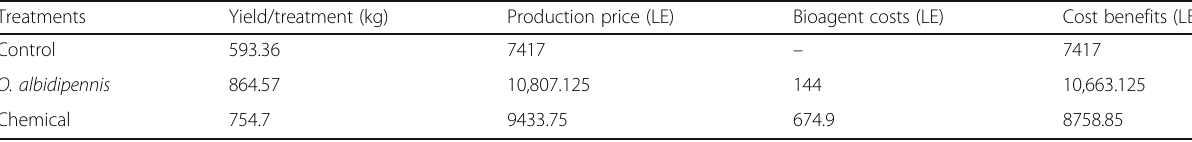
Table 3 Total yield production, bioagent costs, and cost benefits of sweet pepper with release of O. albidipennis compared to chemical applications in the experimental tunnels during winter plantation of 2016 – 2017 Treatments Yield/treatment